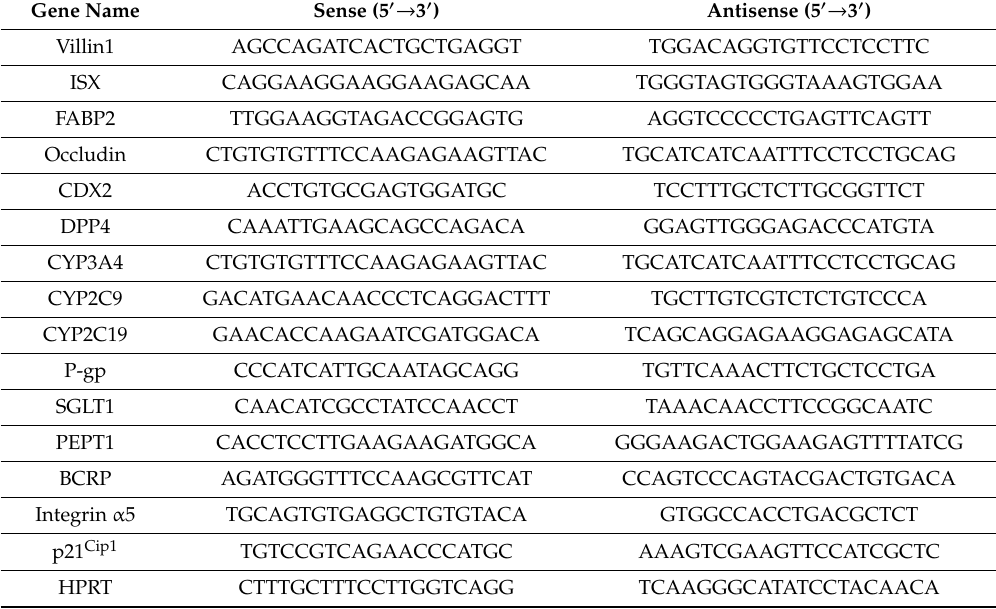
Table 1. Sequences of the primers used for real-time PCR